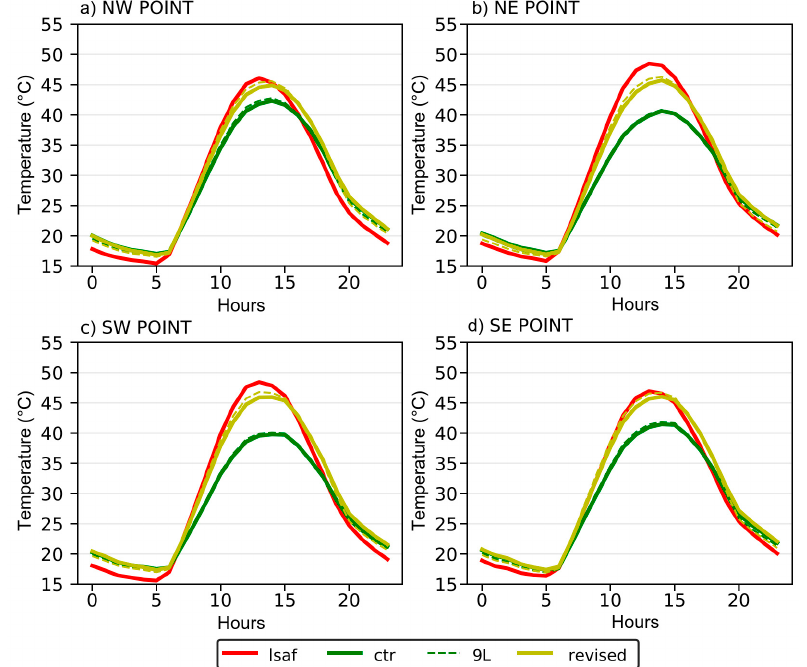
Figure 8. Mean diurnal cycle of temperature (2010 Summer) in the 4 points of the Southern Portugal domain ( a ) North West, ( b ) North East, ( c ) South West ( d ) South East (see Figure S1) comparing the satellite LST (red), and the LST in the control simulation (green), and control with 9 soil layers (dashed green) with the simulation using ESA-CCI vegetation cover (revised in yellow, and with the 9 soil layers dashed